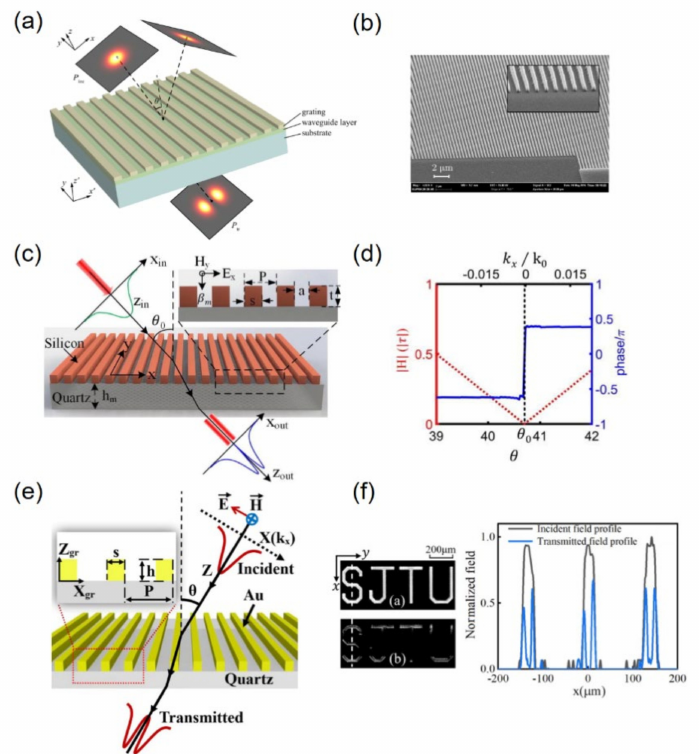
Figure 4. ( a ) Schematic and ( b ) photograph of guided-mode resonant diffraction grating for first- order differentiation; adapted with permission from [131] © The Optical Society. ( c ) The schematic and ( d ) spatial spectral transfer function of the optical spatial differentiator based on subwavelength high-contrast gratings. Adapted with permission from [132], AIP Publishing, 2018. ( e ) Schematic of the first-order differentiator based on subwavelength metallic gratings. ( f ) The experimental results for the incident and transmitted images (left) and the normalized field profiles at the position of white dashed line. Adapted with permission from [133] © The Optical